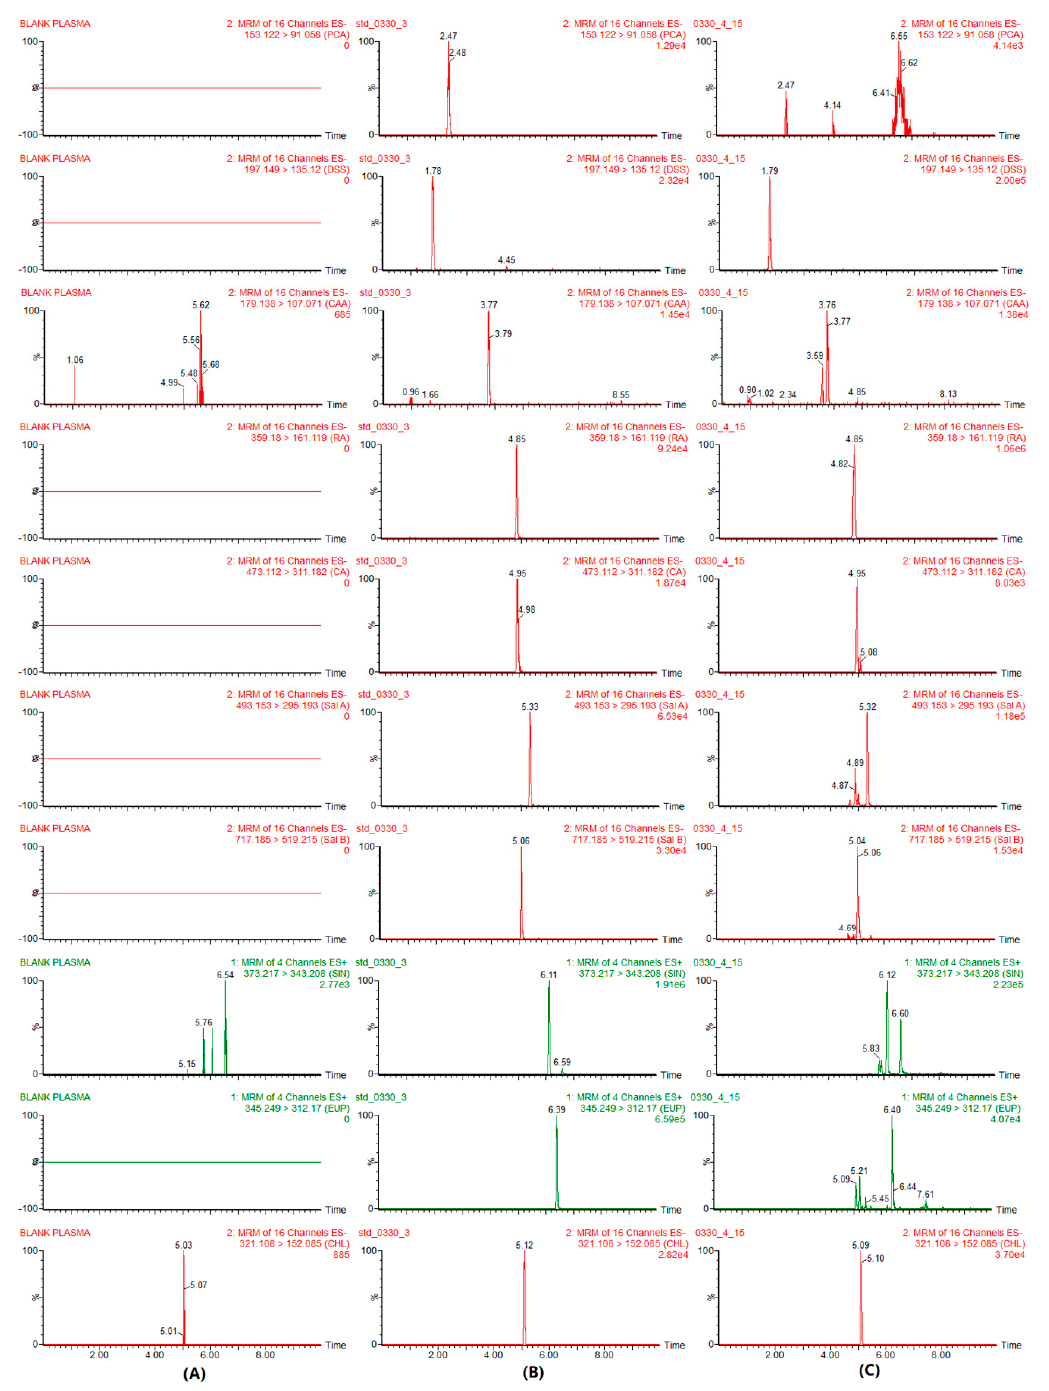
Figure 1. Typical multiple reaction monitoring (MRM) chromatograms of blank plasma ( A ); blank plasma spiked with the nine analytes and IS ( B ); a representative plasma sample at 15 min after oral administration of the Orthosiphon stamineus Benth. (OS) extract ( C ).